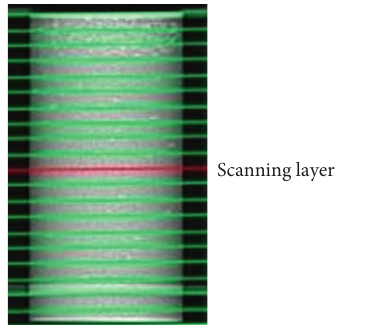
Figure 4: Spatial locations of CT scans for a rock subjected to freeze-thaw cycles.